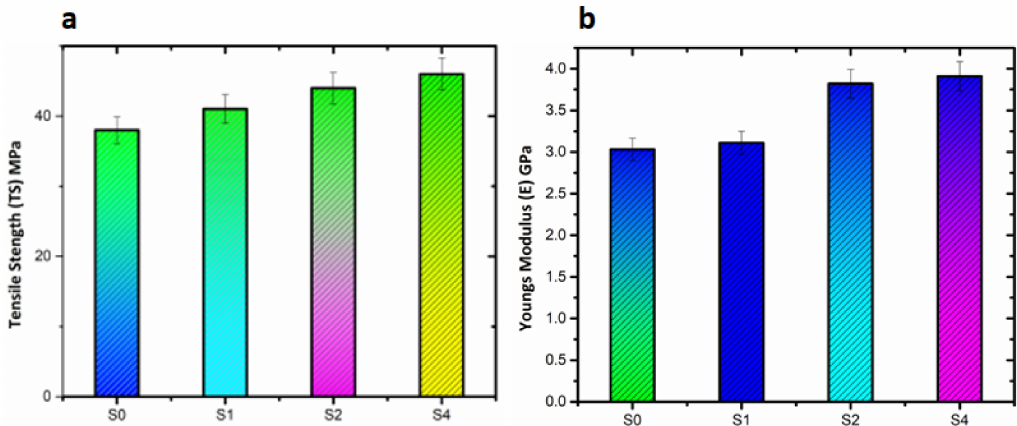
Figure 6. Mechanical properties of pristine PS and PS/Sepiolite composites: ( a ) Tensile Strength (TS) and ( b ) Young’s Modulus